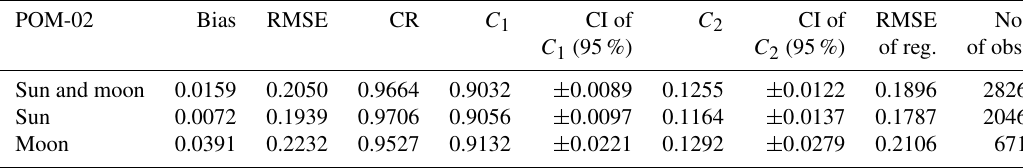
Table 9. Same as Table 4 except for the AOD (PWV) from the Sun and the moon. Wavelength Bias RMSE CR C 1 CI of C 2 CI of RMSE No. (nm) C 1 (95%) C 2 (95%) of reg. of obs. 340 380 − 0 . 0289 0.0425 400 − 0 . 0058 0.0369 0.9700 0.9832 500 0.0068 675 0.0039 0.0216 0.9717 870 0.0020 0.0149 0.9806 940 − 0 . 0236 0.1376 0.9751 1020 0.0047 0.0152